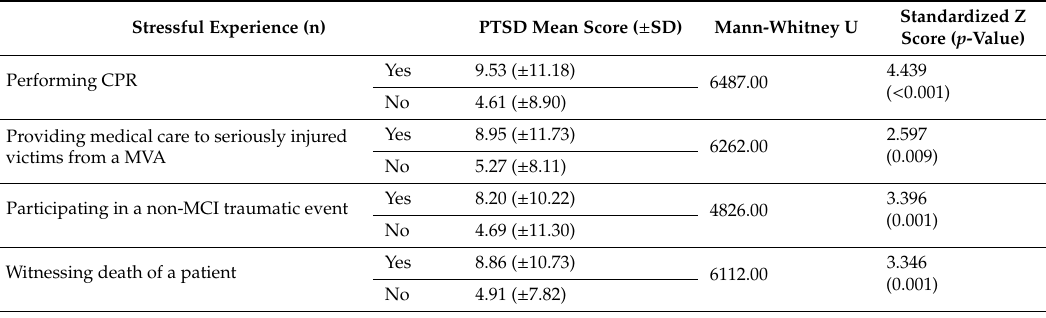
Table 3. Effect of experiencing stressful events on levels of PTSD among MDA youth volunteers (N = 236).